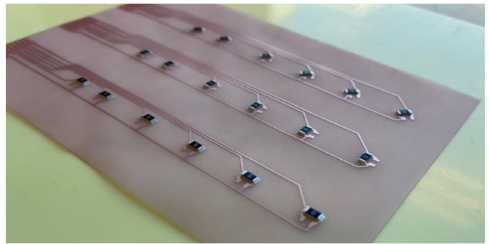
Figure 11. Real-life PET-Cu foil with components.